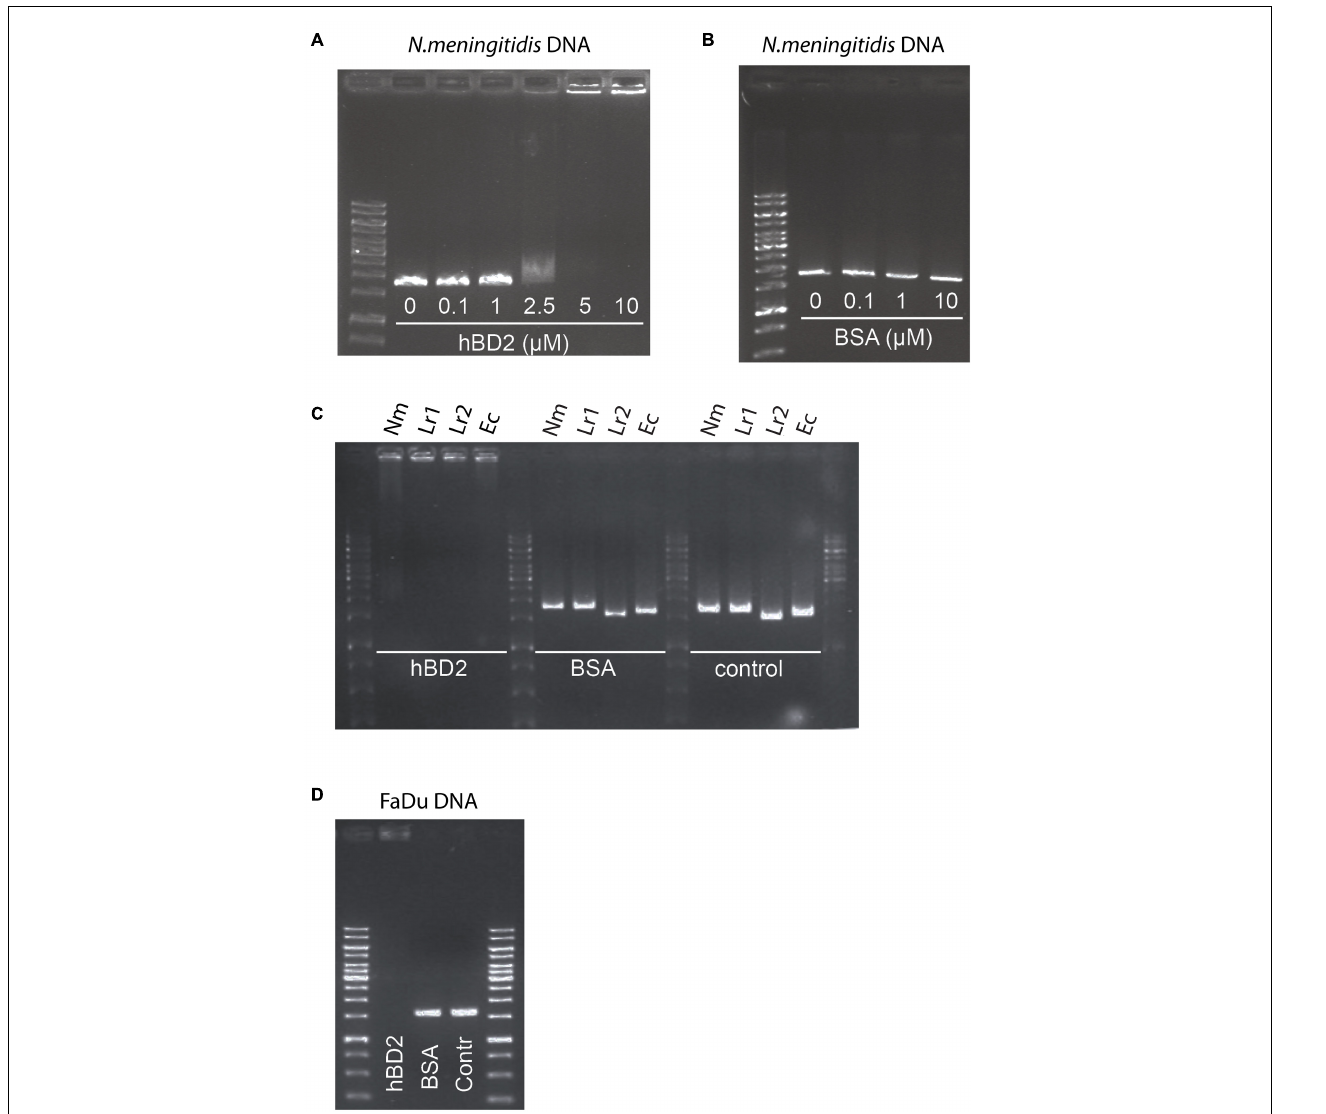
FIGURE 5 | Human beta-defensin 2 binds both bacterial and human DNA in vitro . To assess the in vitro binding of hBD2 to DNA, an electrophoretic mobility shift assay was performed. (A) N. meningitidis DNA, as a 1786 bp non-coding DNA fragment, was incubated with hBD2 (0.1, 1, 2.5, 5 or 10 µ M) for 1 h. (B) BSA (0.1, 1 or 10 µ M) was used as a negative control. (C) N. meningitidis DNA (Nm) as a fragment of 1786 bp, L. reuteri DNA as two fragments of 1610 bp (Lr1) and 1791 bp (Lr2) and an E. coli DNA fragment (Ec) of 1702 bp, were incubated with hBD2 at a concentration of 5 µ M for 1 h. BSA at a concentration of 5 µ M was used as a negative control and incubated with the same DNA fragments for 1 h. Bacterial DNA fragments without peptide served as second negative control (control). (D) Human pharyngeal epithelial cell FaDu DNA as a fragment of 1735 bp was incubated with hBD2 at a final concentration of 5 µ M for 1 h. Incubation of FaDu DNA fragment with BSA at a final concentration 5 µ M and without peptide (Contr) served as negative control. After incubation, samples were run on an agarose gel. Representative images are shown. The assays were performed